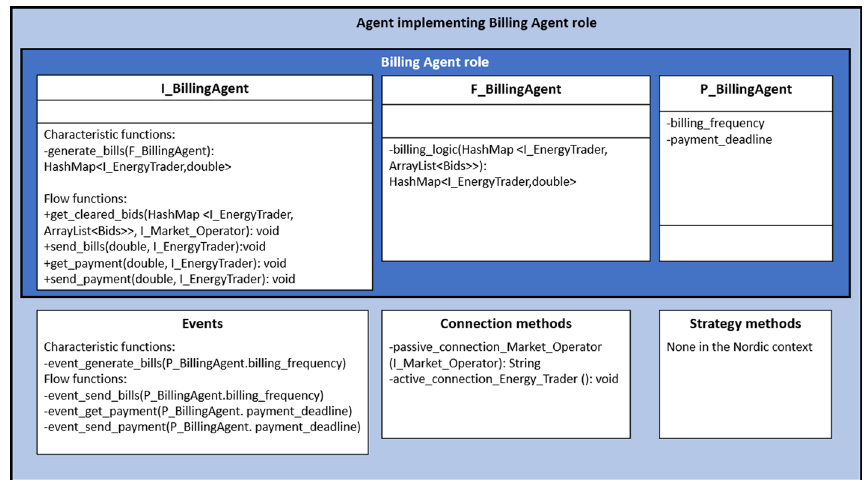
Fig. 10 Interfaces, classes and methods for Billing Agent role implementation